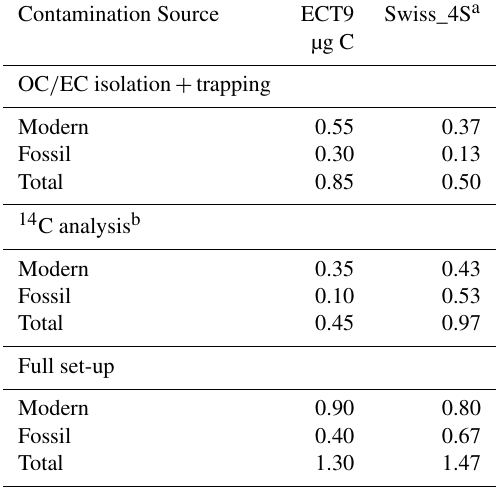
Table 4. Comparison of the procedural contamination with extrane- ous carbon for aerosol reference materials partitioned into organic carbon (OC) and elemental carbon (EC) with the ECT9 or Swiss_4S protocols based on their 14 C contents. We assume a measurement uncertainty of 50% (see Sect.